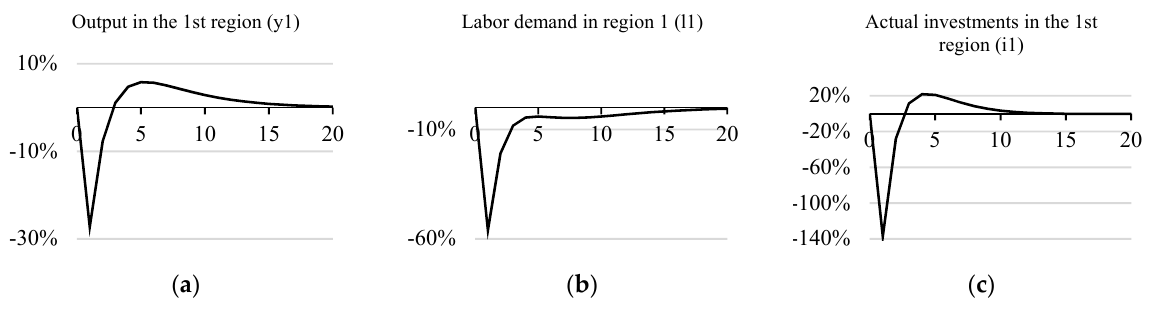
Figure 2. Reduction in budget spending in the first region. A consequence of the reduction in current budget spending is a decrease in regional product, employment, and investment (Figure 3).